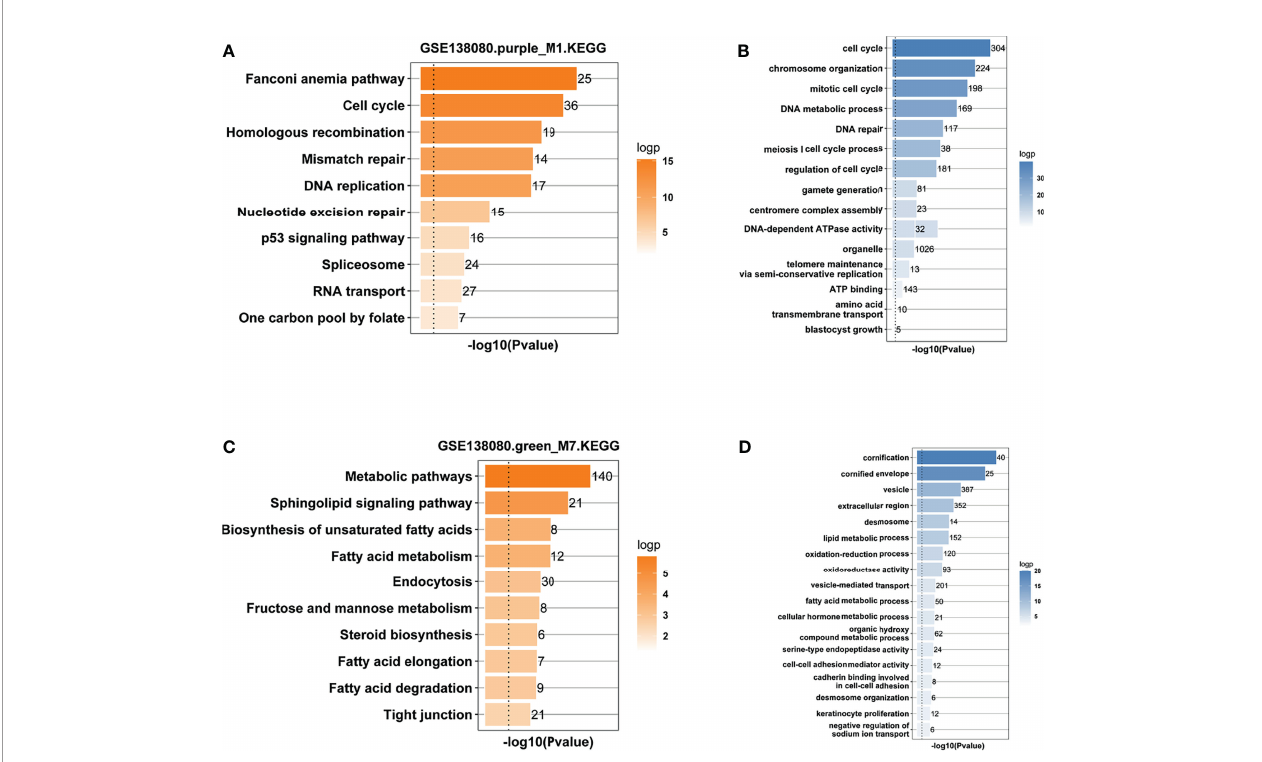
FIGURE 4 | Functional enrichment analysis. (A) KEGG enrichment analysis of genes in the purple_M1 module. (B) GO enrichment analysis of genes in the purple_M1 module. (C) KEGG enrichment analysis of genes in the green_M7 module. (D) GO enrichment analysis of genes in the green_M7